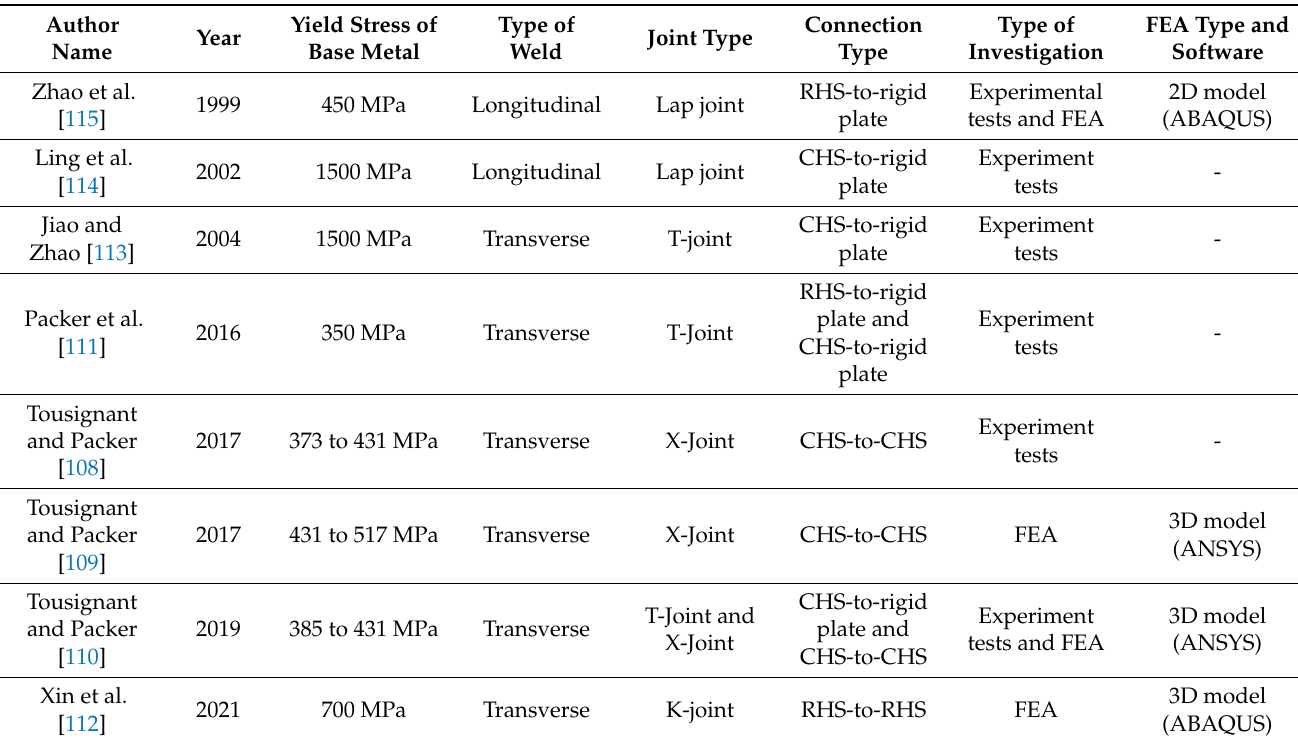
Table 4. Static strength of fillet welded joints on hollow sections.